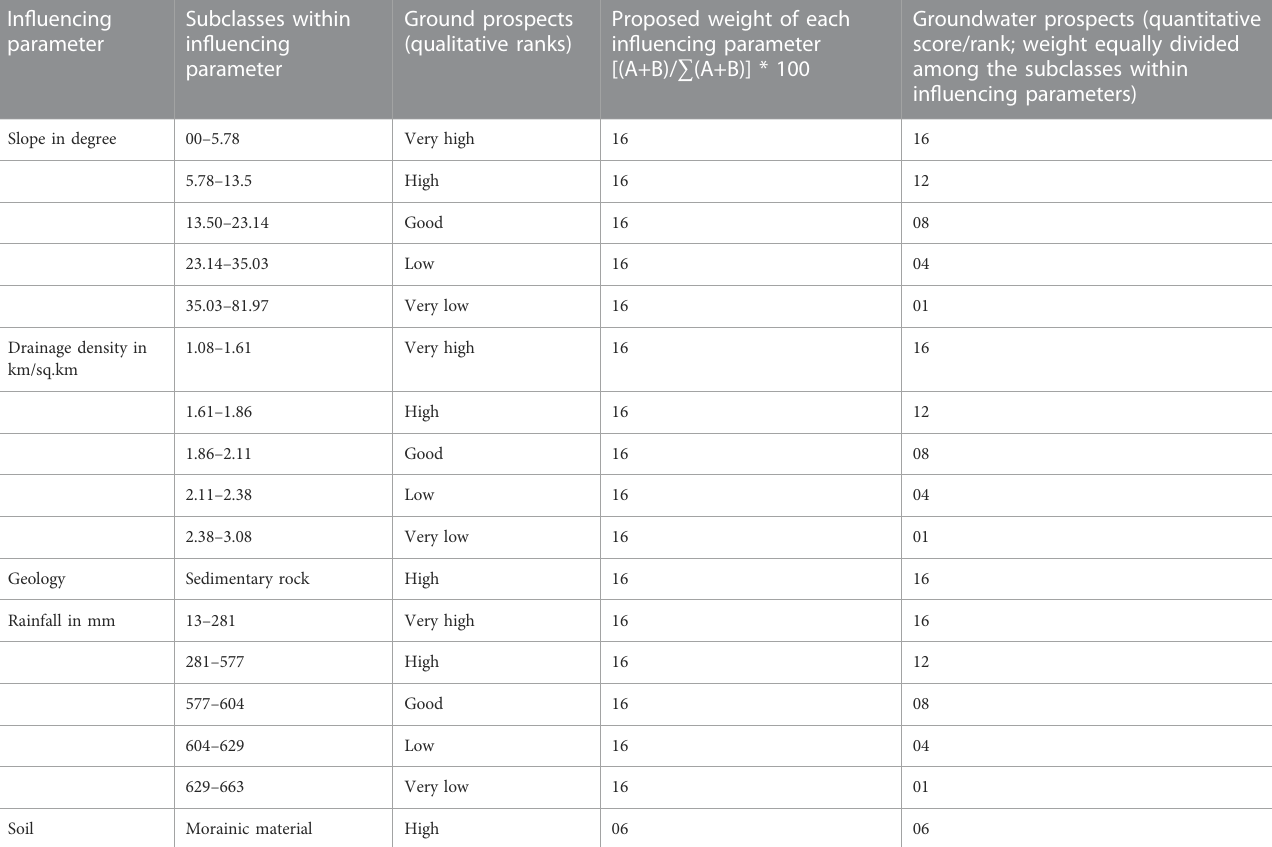
TABLE 3 Details of parameters that in fl uence groundwater potential. In fl uencing